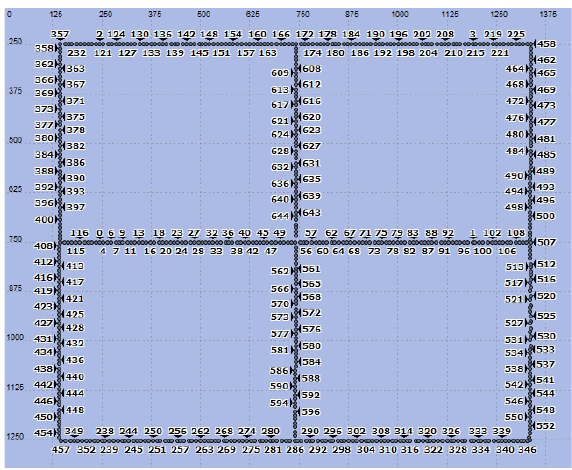
Figure 9. Arrangement of nodes. Table 4. Simulation parameter settings.